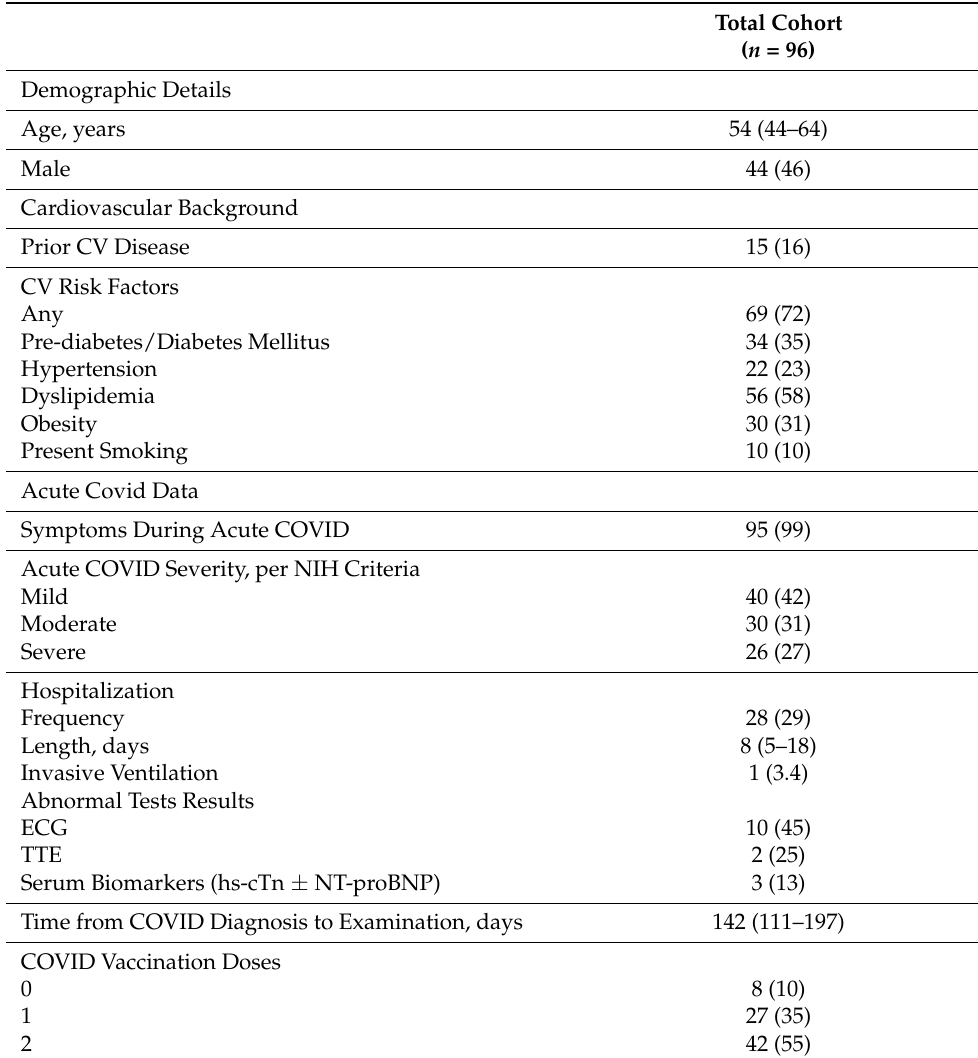
Table 1. Baseline patient